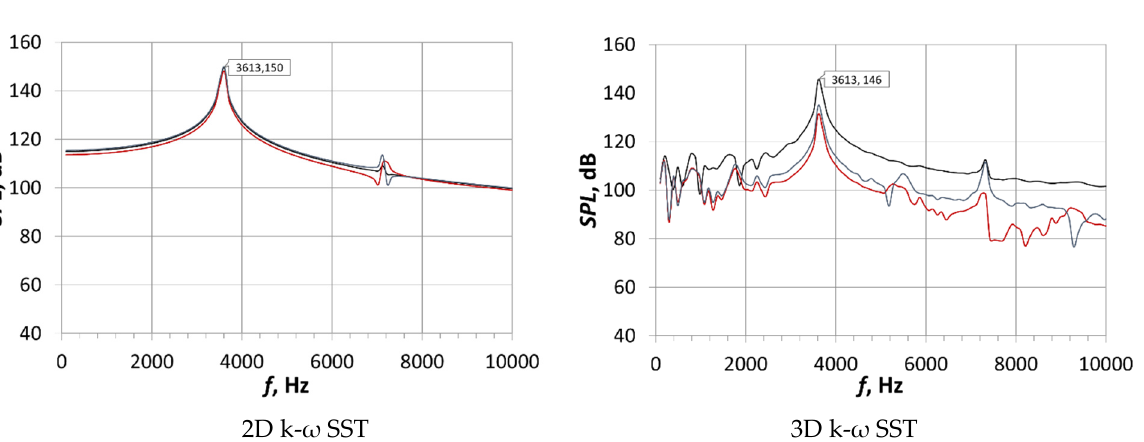
Figure 21. Spectral analysis of SPL for velocity equal to 70 m/s—experimental data.